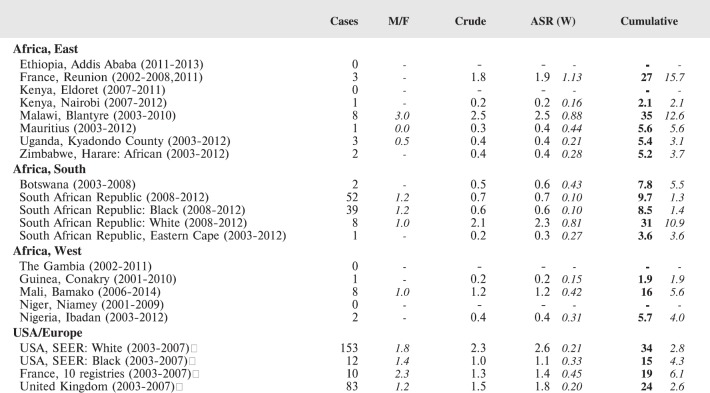
Crude, age-standardised (world) and cumulative (0–14) incidence rates (per million) and standarderrors—hepatoblastoma.